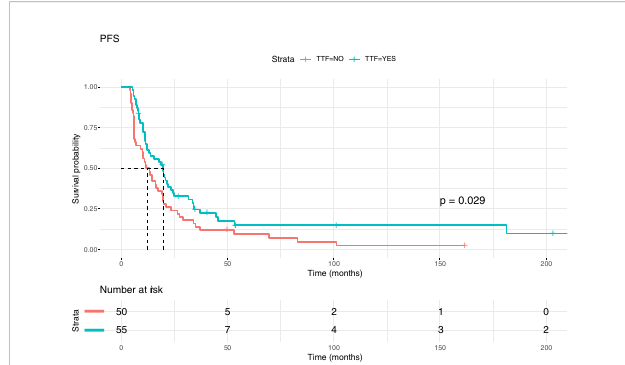
FIGURE 6 Kaplan-Meier curves showing overall survival (OS) in GBM patients with and without TTFields therapy.